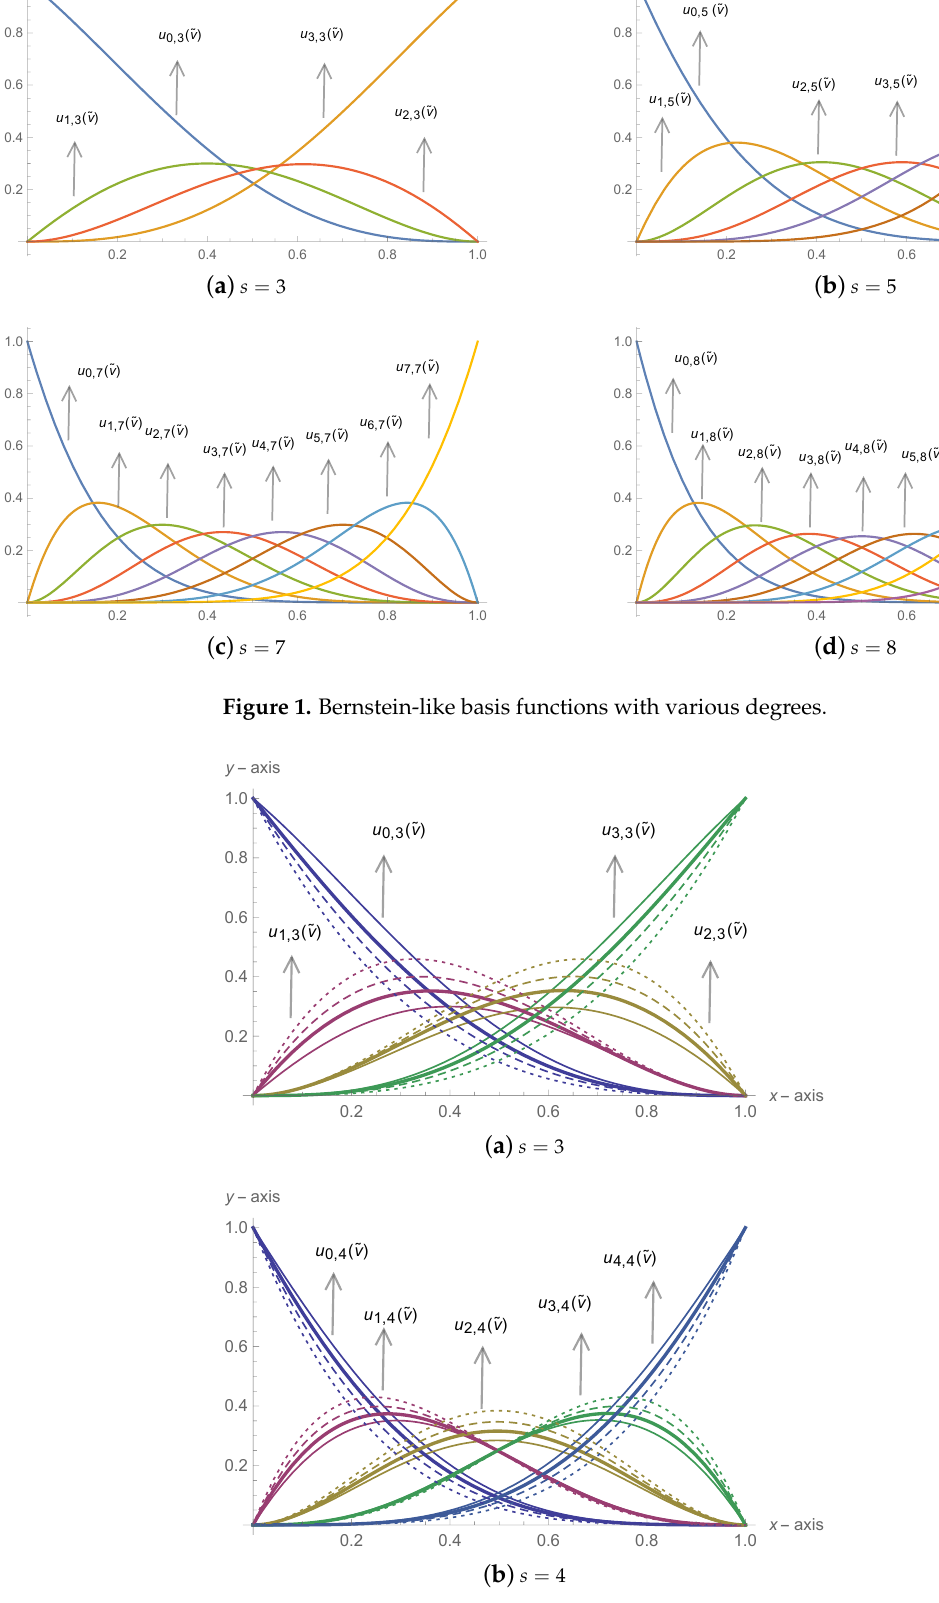
Figure 2. Bernstein-like basis functions with various shape parameter